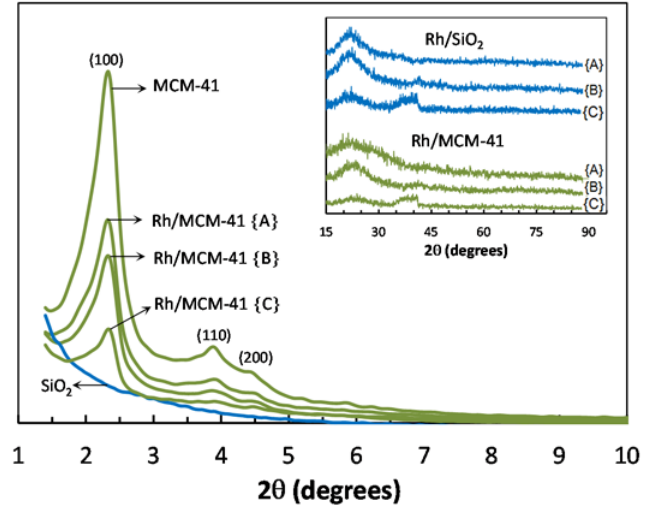
Figure 6. Small and wide angle XRD patterns of pure supports SiO 2 and MCM-41, impregnated with Rh ( A ); after catalytic testing ( B ); and after catalytic testing with addition of water ( C ). Catalytic testing at same conditions as indicated in Table